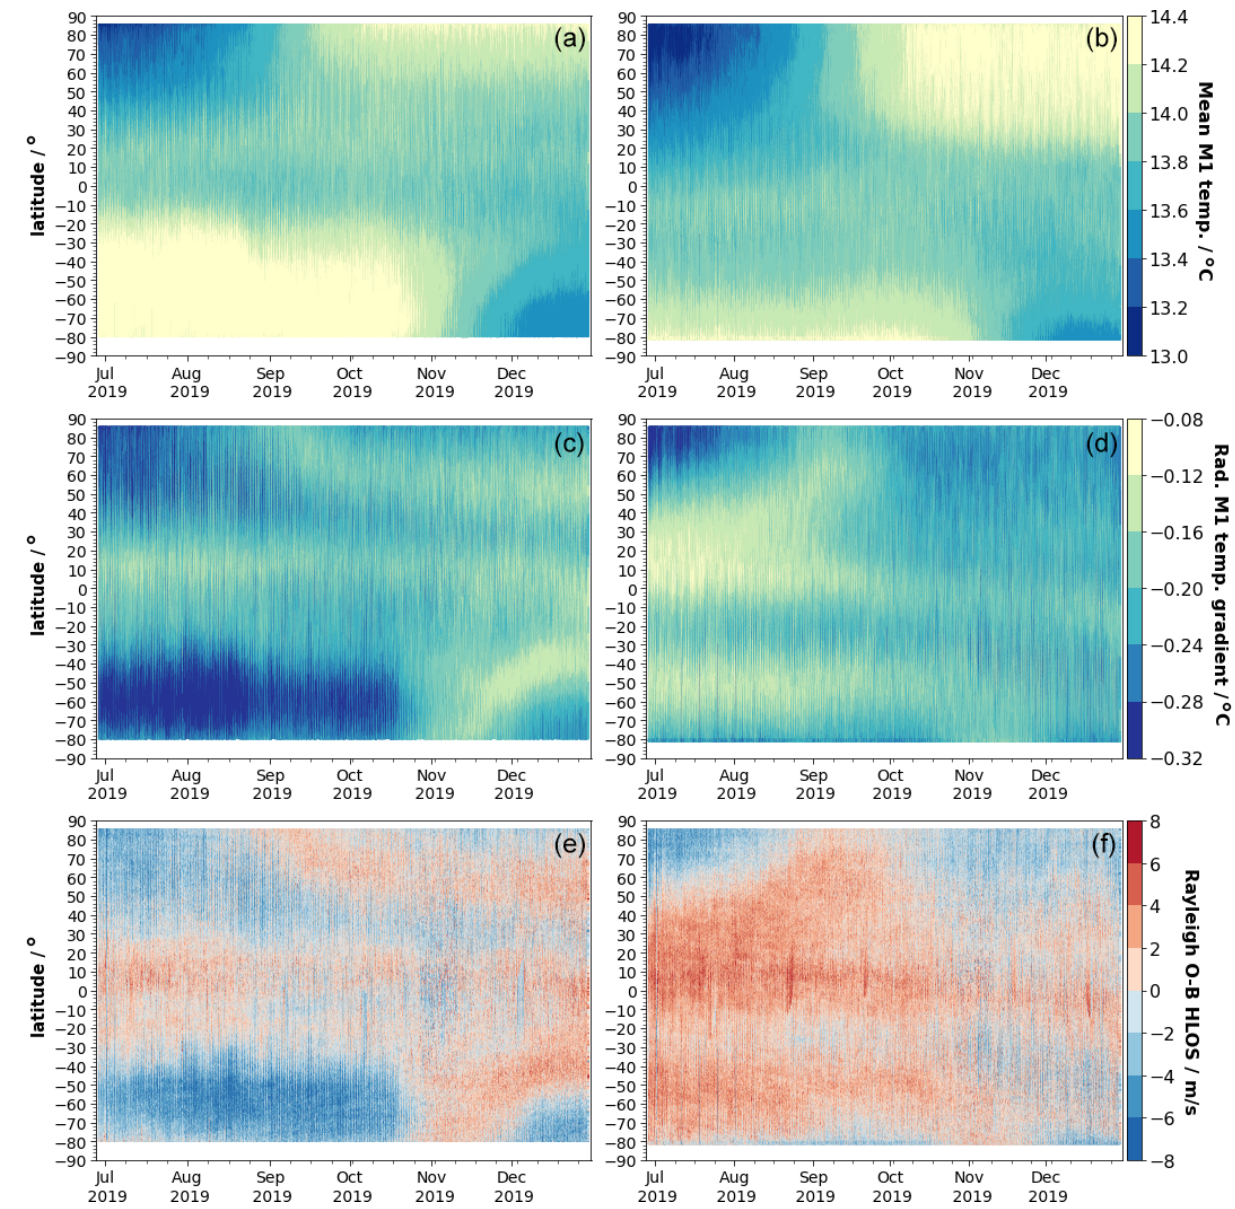
Figure 7. Hovmöller diagrams of the average over all M1 temperatures (a, b) , the radial temperature gradient of the M1 telescope (c, d) and the Rayleigh clear E(O − B) HLOS values (e, f) from 28 June to 31 December 2019 split up into ascending (a, c, e) and descending (b, d, f) orbit